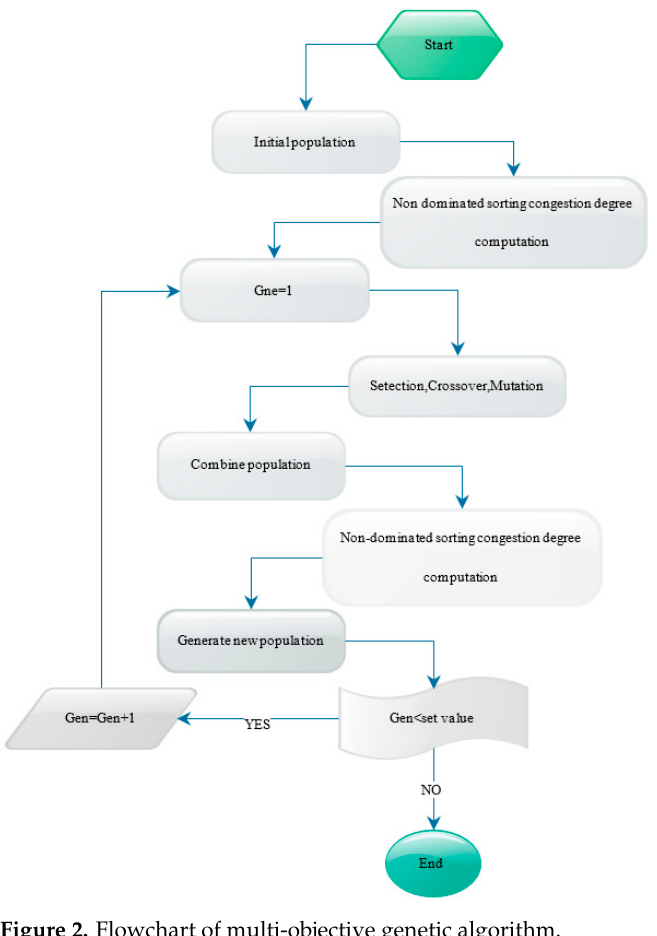
Figure 2. Flowchart of multi ‐ objective genetic algorithm.